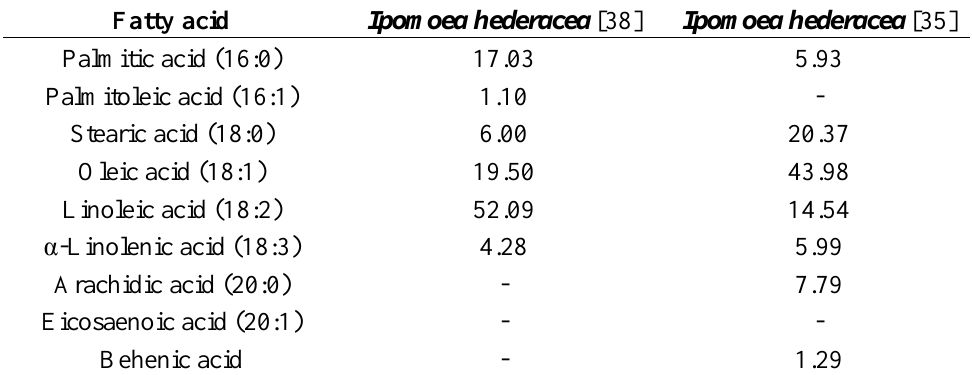
Table 6. Fatty acid profile (%) of I. hederacea seed oil.